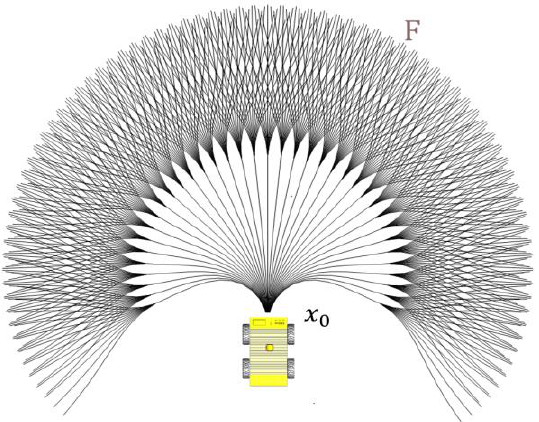
Figure 3. Illustration of the state lattices of the nonholonomic robot.